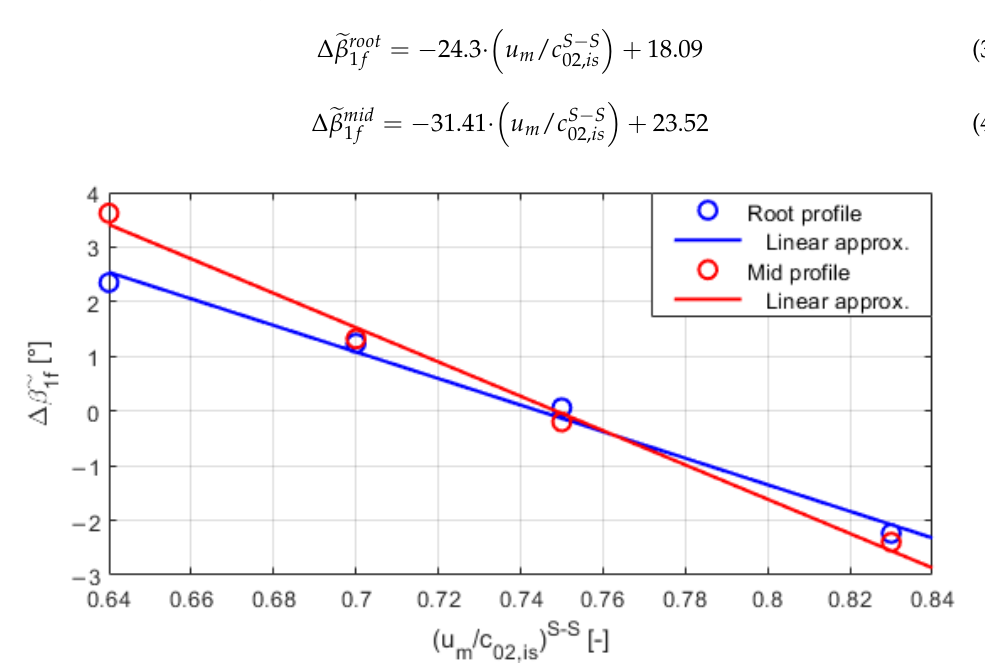
Figure 13. Linear dependence of the angular difference Δ𝛽(cid:3560) (cid:2869)(cid:3033) at the root bucket profile.